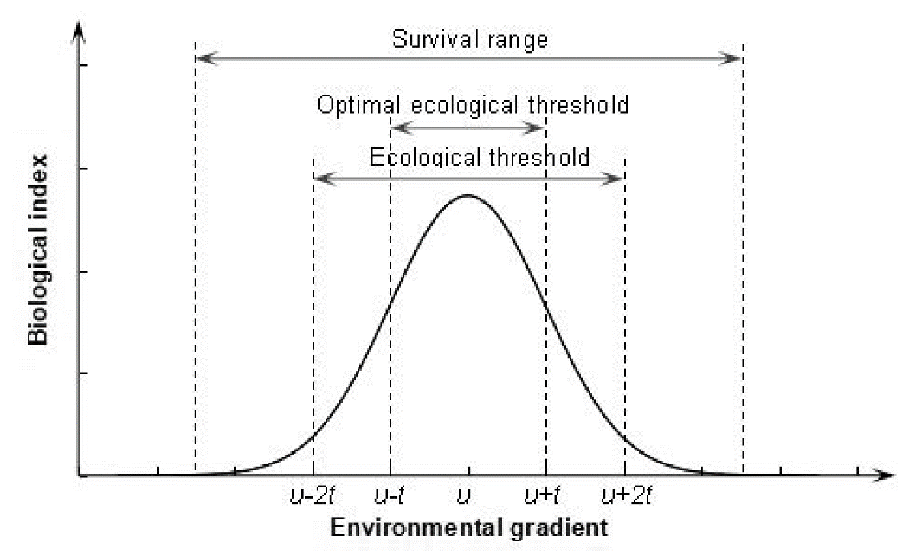
Figure 3. Gaussian curve and ecological threshold: u is the corresponding environmental factor value when the corresponding biological index reaches the maximum, and t is the tolerance of the index, which is an index to describe the ecological threshold of biological species. The ecological threshold interval of a biological species is [u − 2t, u + 2t], and the optimum ecological threshold interval is [u − t, u + t]. The species can only survive in the survival range.